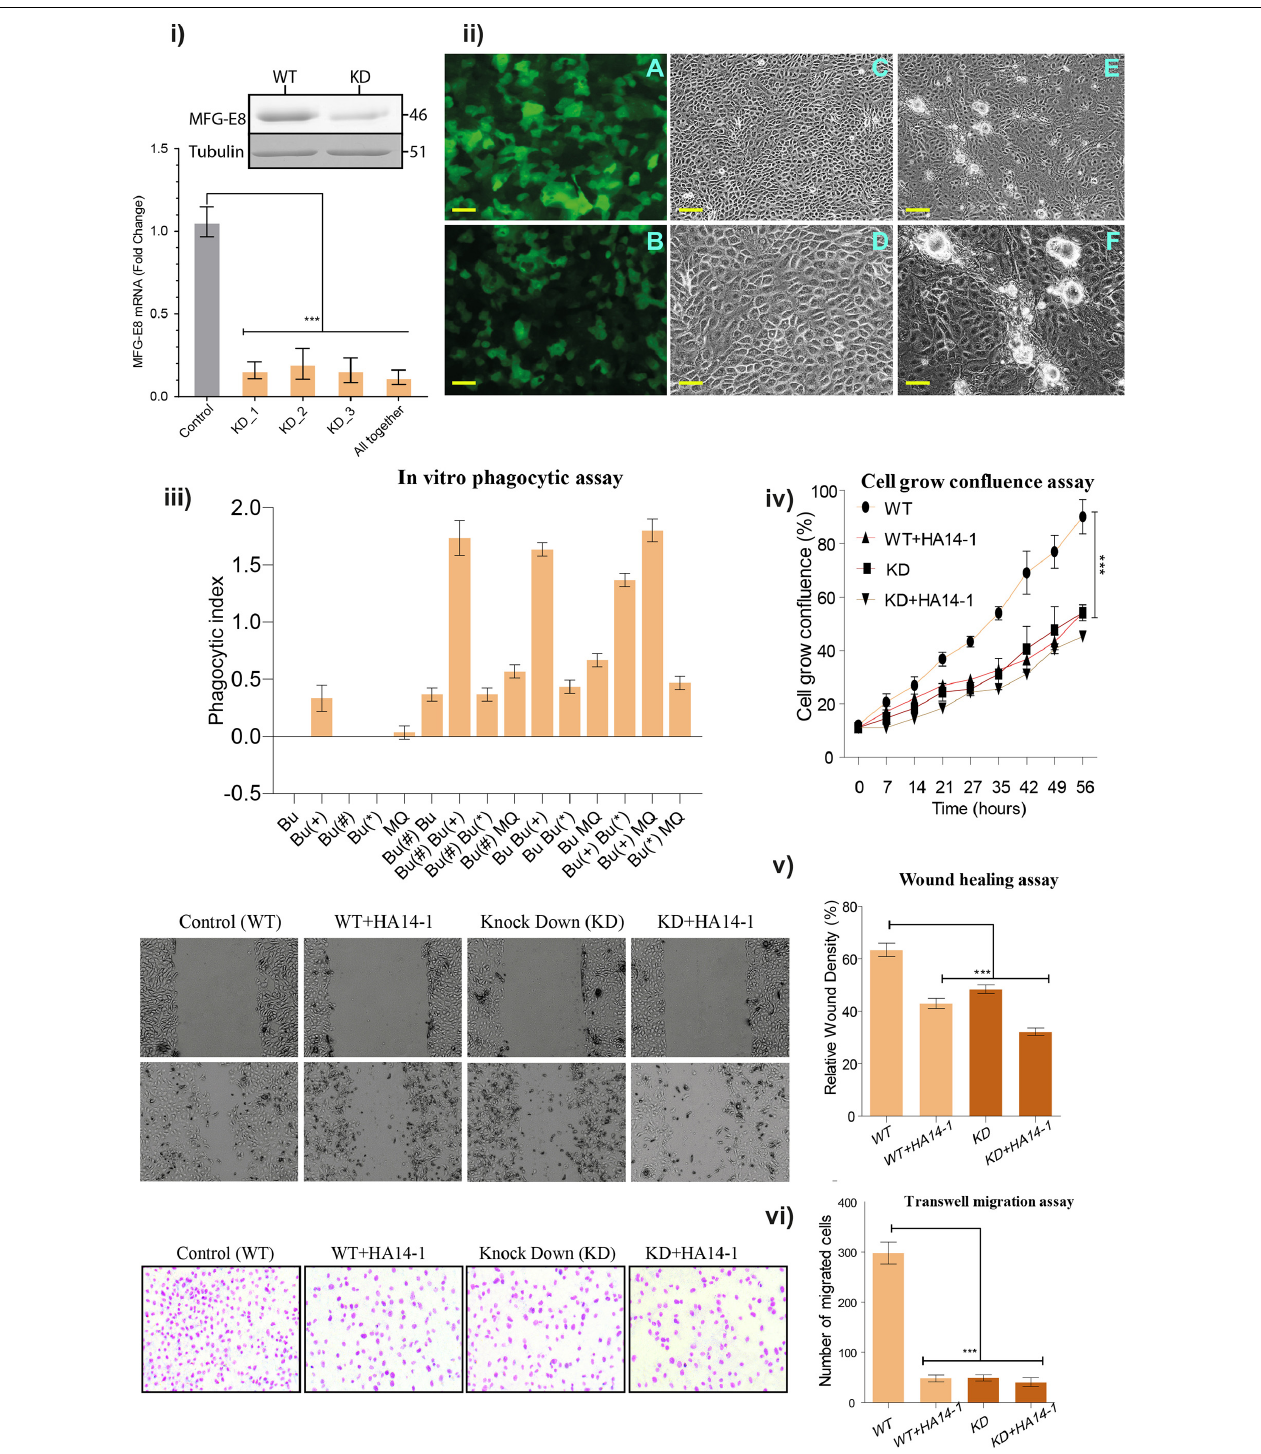
FIGURE 2 | (i) Quantitative real-time PCR assay: Real-time PCR reaction was performed using three independent shRNA (KD_1, KD_2, and KD_3) and in a combination of all together. All the reactions were performed in three biological replicates and repeated at three replicates, and values are shown in ± SEM as error bars. (ii) Stable transfection of buffalo mammary epithelial cells (BuMECs) cells. (A) Transfected BuMEC cells over-expressing non-target scramble shRNA pLKO.1-puro-CMV-tGFP vector. (B) Transfected BuMEC cells with MFG-E8 specific shRNA containing pLKO.1-puro-CMV-tGFP vector, respectively. (C) Transfected BuMEC cells over-expressing non-target scramble shRNA pLKO.1-puro-CMV-tGFP vector at 72 h of growth, magnification 200 × . (D) The same panel-C cells at